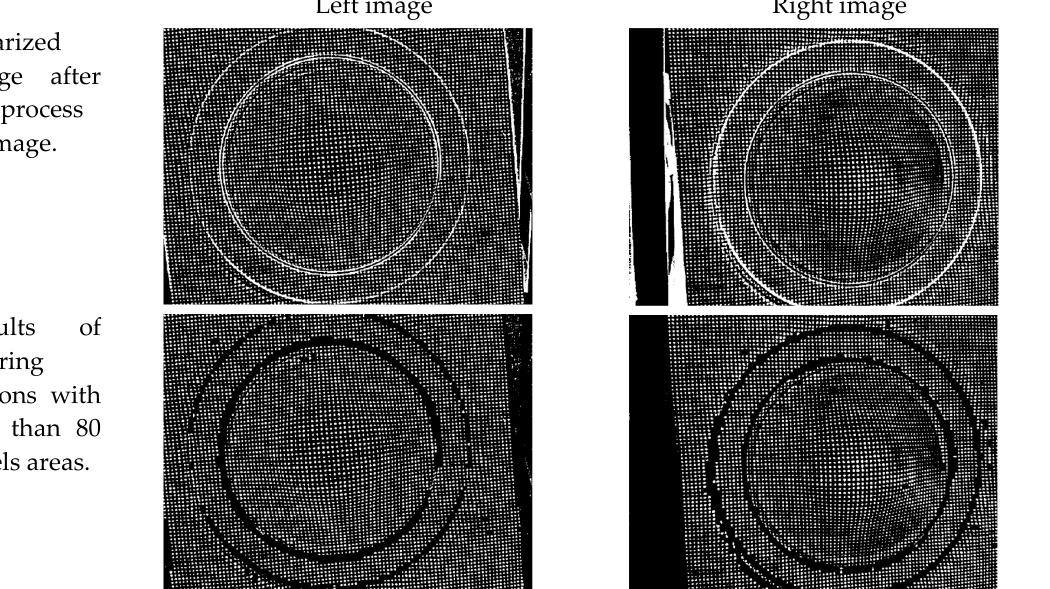
Figure 9. Correlation on one matching projected by a four-point initialization using a window of 31 × 31 pixels on a zone of 21 × 21 pixels.